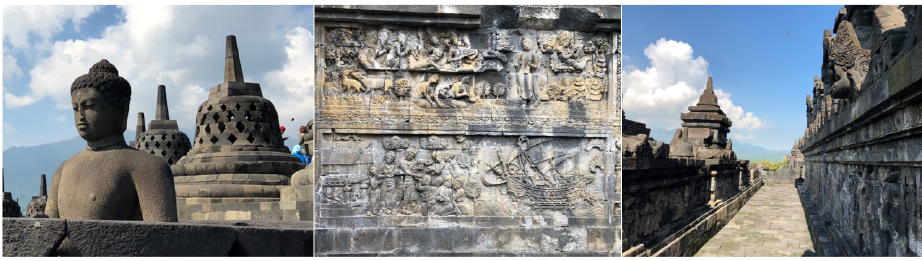
Figure 3. From left to right: photograph of the Buddha statue, the relief, and the narrow